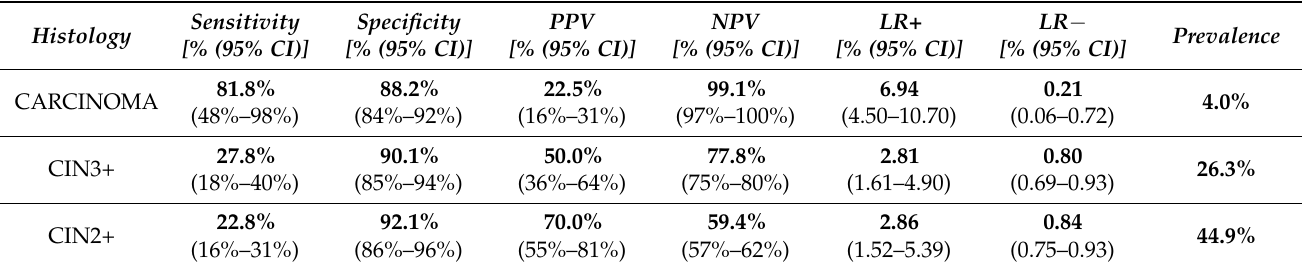
Table 5. Hepika test accuracy in function of histology (95% confidence interval (CI)).